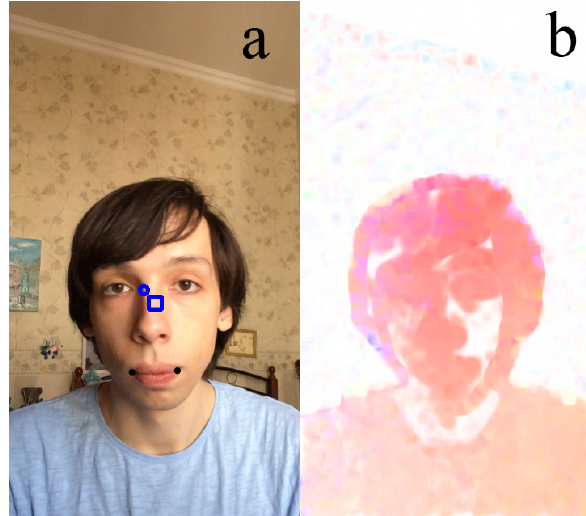
Figure 7. Original output and the output of the NARX